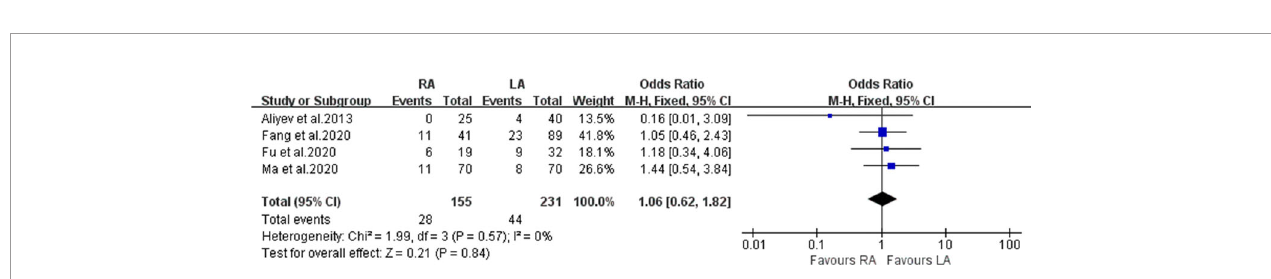
FIGURE 4 | Forest plot for complication